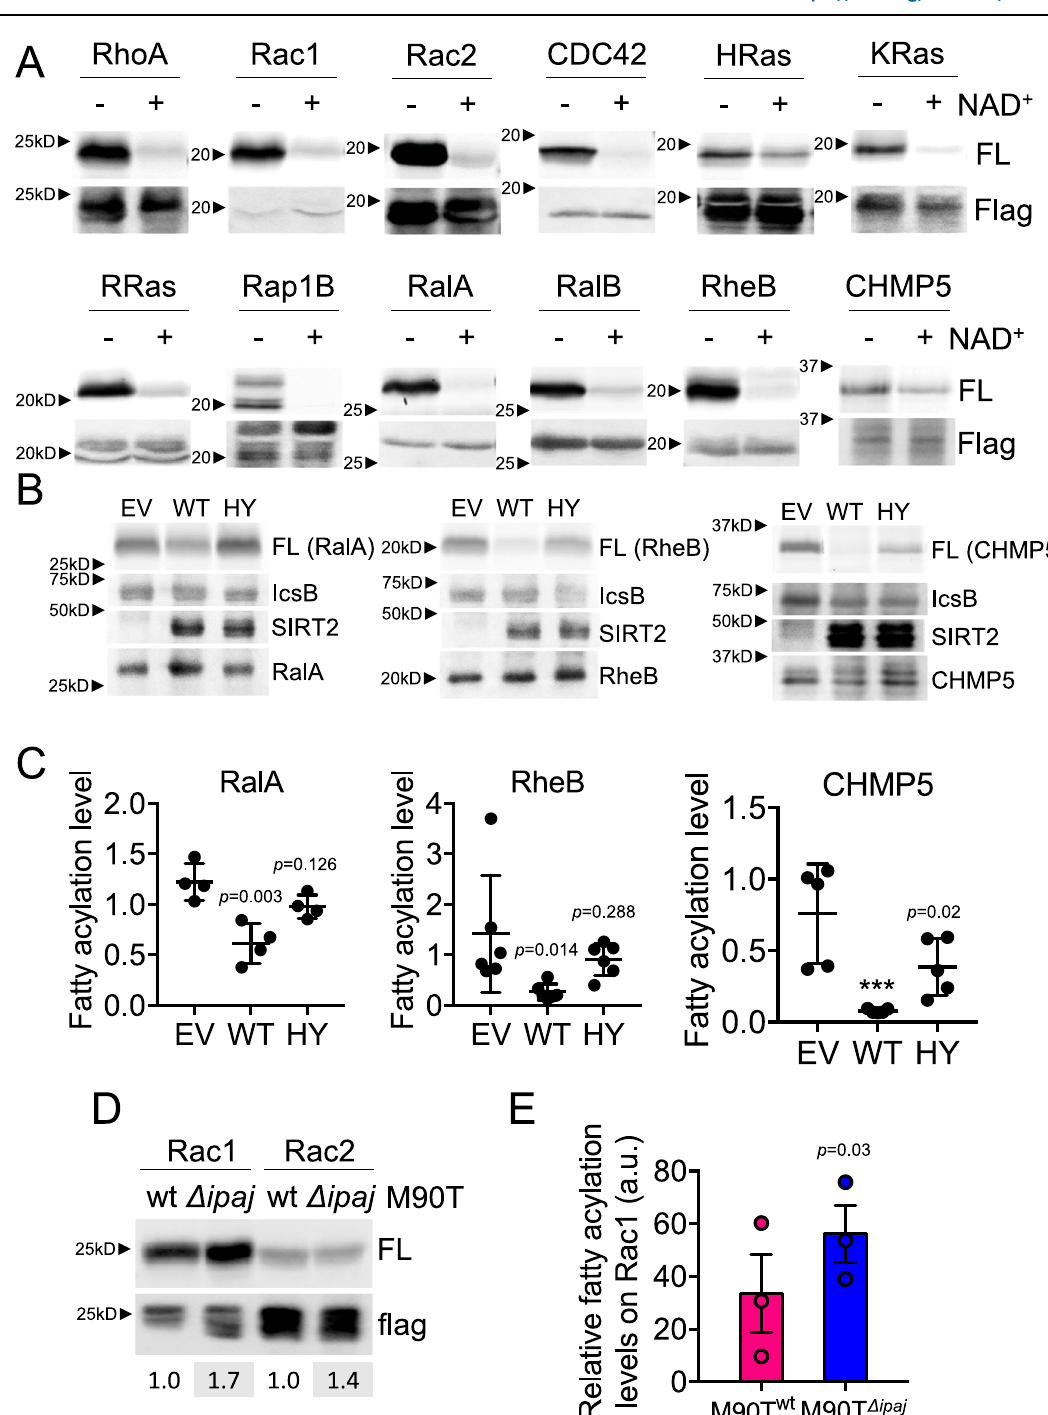
Fig. 4 | SIRT2 is a potent lysine defatty-acylase that counteracts IcsB. A In-gel fl uorescence detection of lysine fatty acylation of Flag-tagged IcsB substrate pro- teins treated with 5 μ M of SIRT2, with or without 1mM of NAD + in vitro. B In-gel fl uorescence detection of lysine fatty acylation of Flag-tagged IcsB substrates in HEK293T cells that were also transfected with Flag-tagged IcsB and SIRT2. Repre- sentative images from at least three independent experiments are shown. EV, empty vector. WT, SIRT2 WT. HY, SIRT2 HY. FL, fl uorescence (indicative of lysine fatty acylation level on substrate proteins). Flag, anti-Flag immunoblot